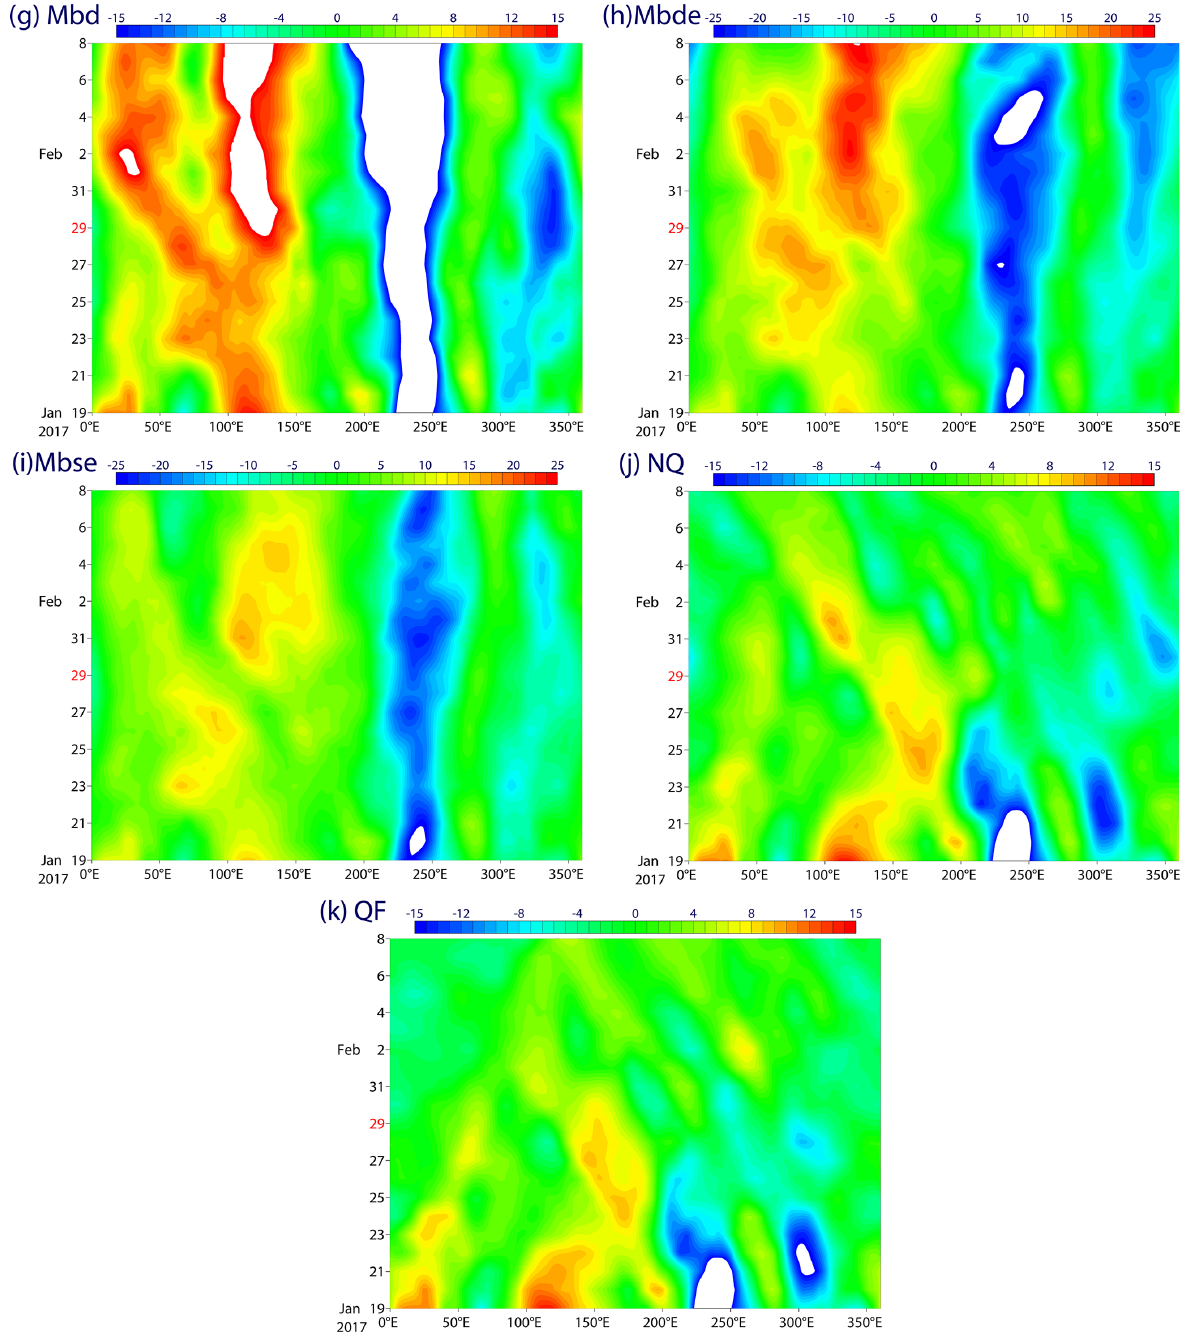
Figure 3. Time–longitude sections averaged over 15 ◦ S–15 ◦ N of the 150hPa level stream function for the standard 20d forecast case: (a) analysis, (b) CF, (c) Ma, (d) Mbb, (e) Mbc, (f) Mbs, (g) Mbd, (h) Mbde, (i) Mbse, (j) NQ and (k) QF.